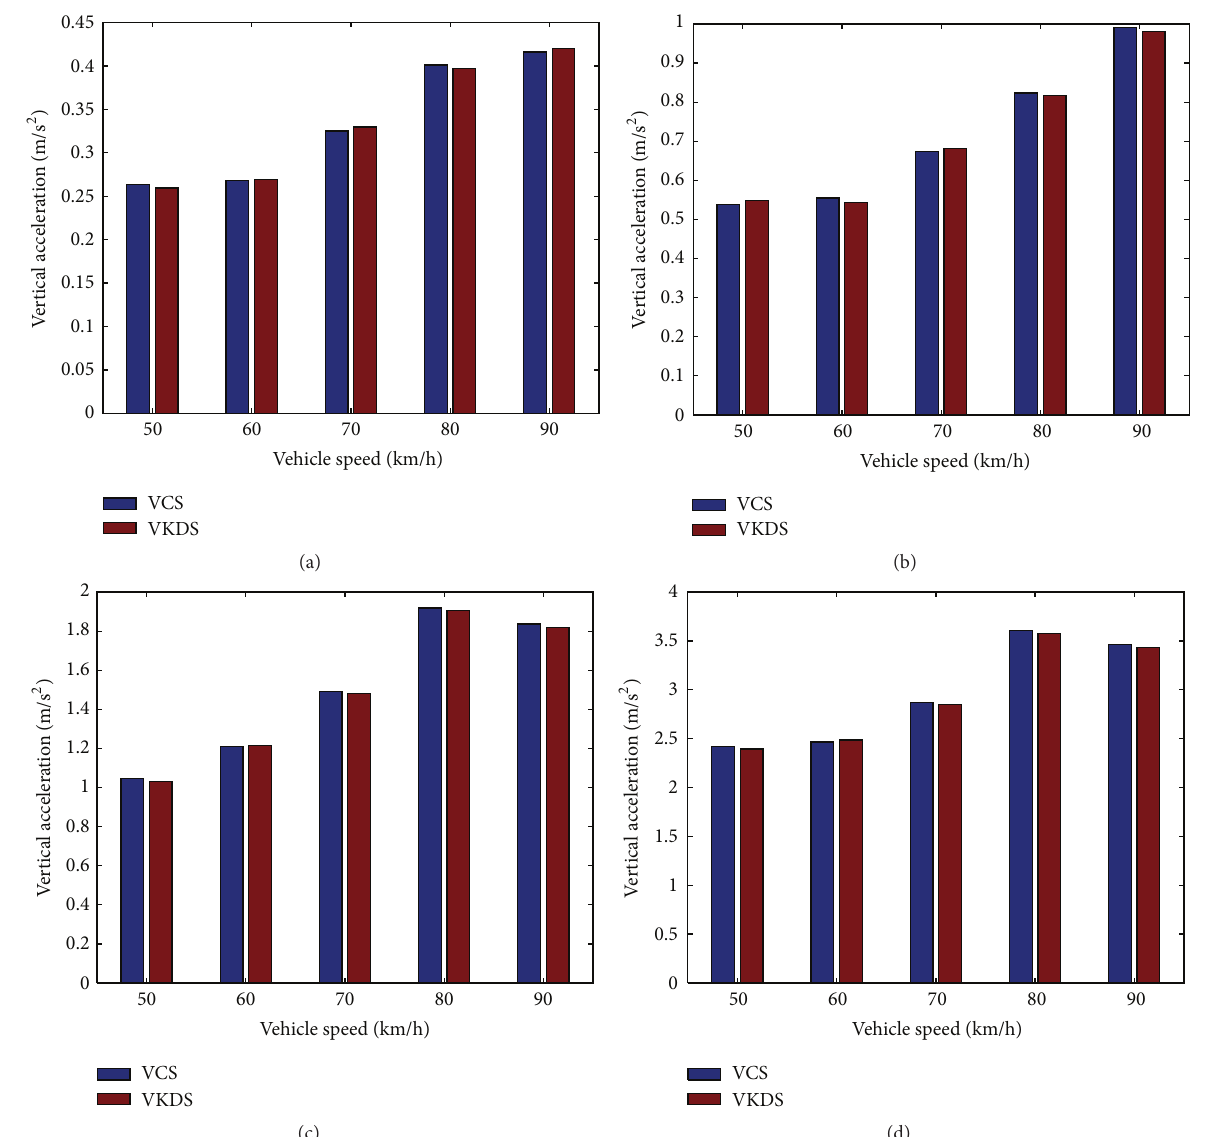
Figure 16: Comparisons of the sprung mass vertical ride responses of the VCS and VKDS: (a) smooth; (b) medium-smooth; (c) medium- rough; (d)